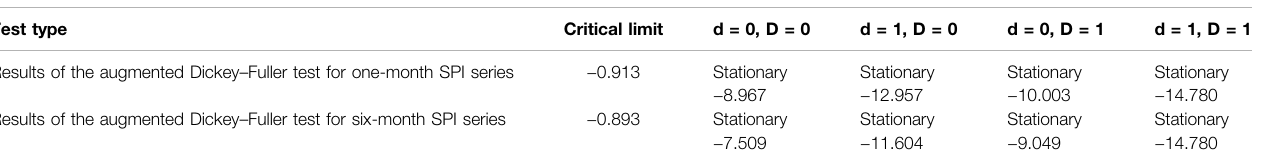
TABLE 4 | Results of the augmented Dickey – Fuller test for drought index time